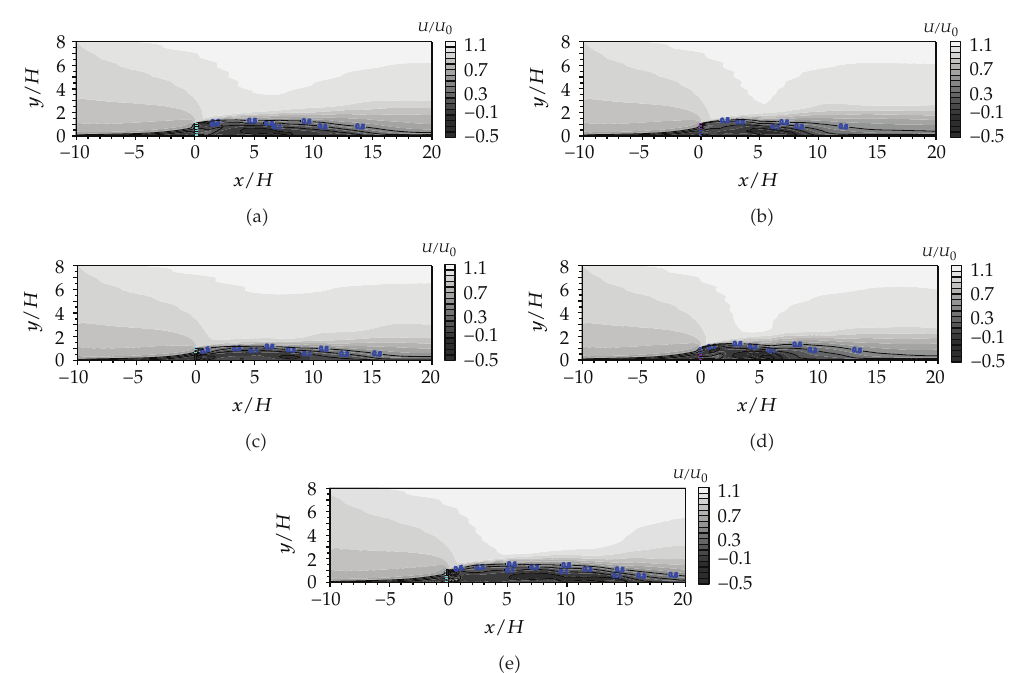
Figure 10: Contour plots of the calculated mean streamwise velocity for various porous fences.